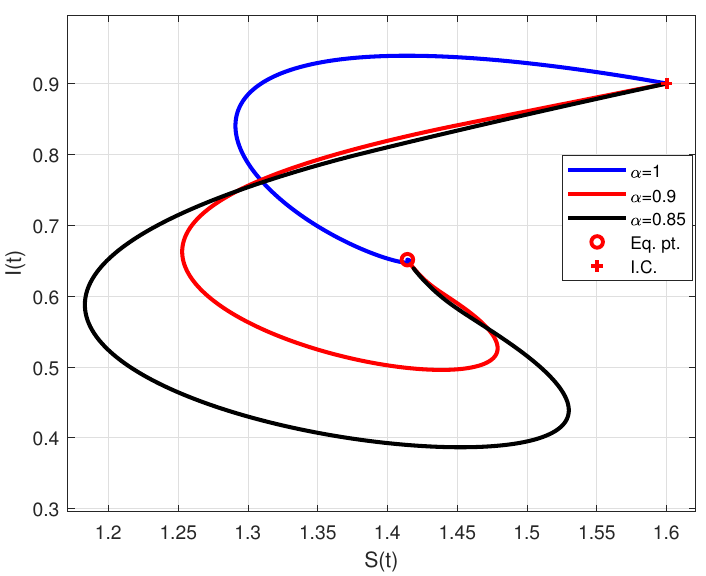
Figure 3. Phase portrait of the model (5) with different α = 0.85,0.9,1 values, the Holling type III function response and the set of parameters Ψ = 0.75, µ = 0.3, η = 0.1, β = 0.3, ρ = 0.15, δ = 0.05 and τ = 0.1. The solutions with the initial condition (I.C.) ( S ( 0 ) , I ( 0 )) = ( 1.6,0.6 ) converges asymptotically to the endemic steady-state solution E ∗ = ( S ∗ , I ∗ ) = ( 1.4142,0.6515 )